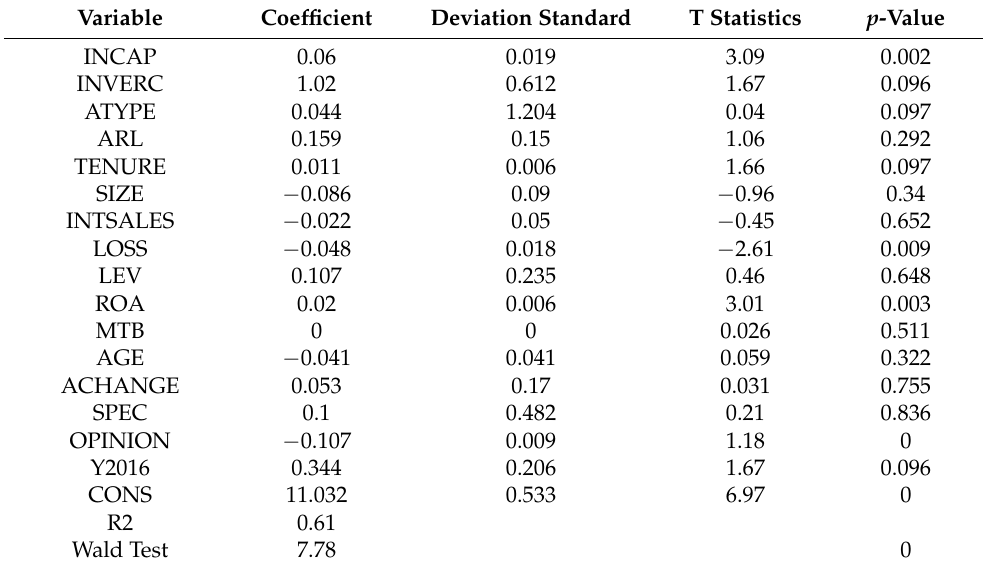
Table 5. The results of estimating the first model using the fixed-effects